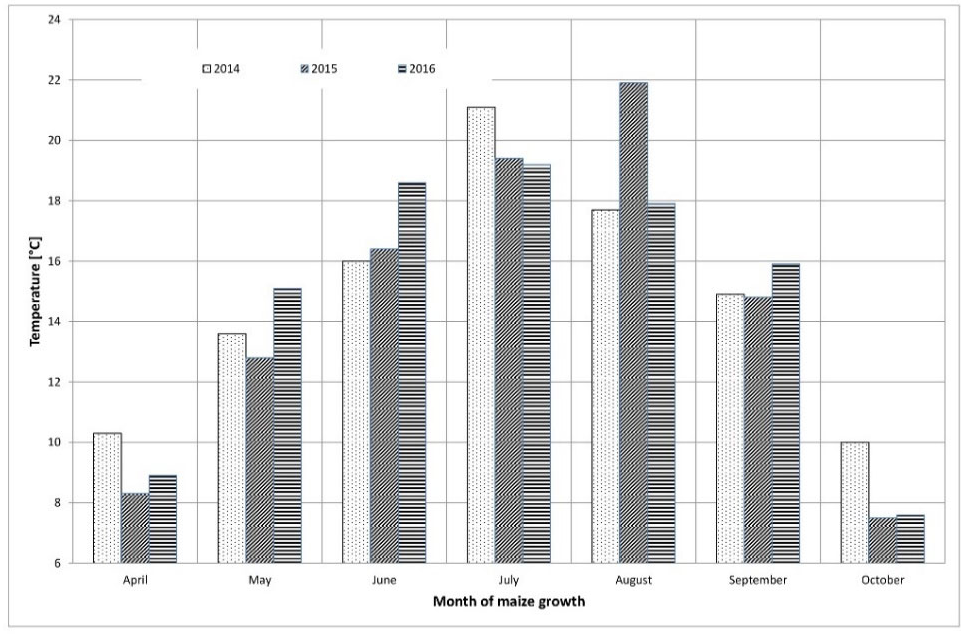
Figure 1. Average monthly temperature in seasons of studies 2014–2016.